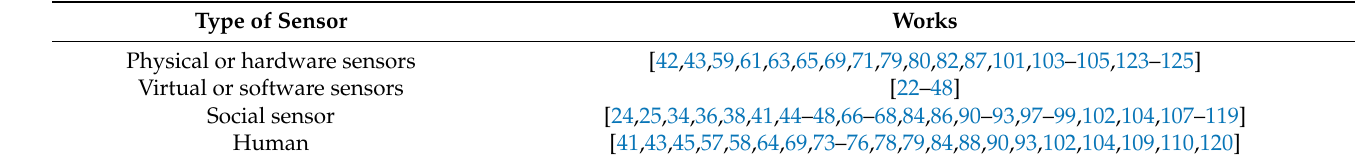
Table 3. Categories of sensors employed in included